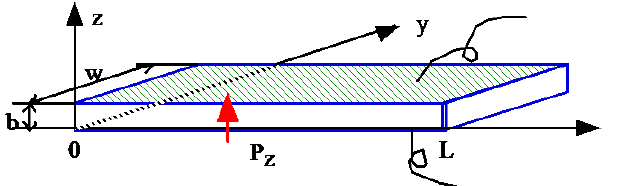
Figure 16. A rectangular piezo-ceramic plate ( L ≫ w ≫ b ) for a longitudinal mode through the transverse piezoelectric effect ( d 31 ).